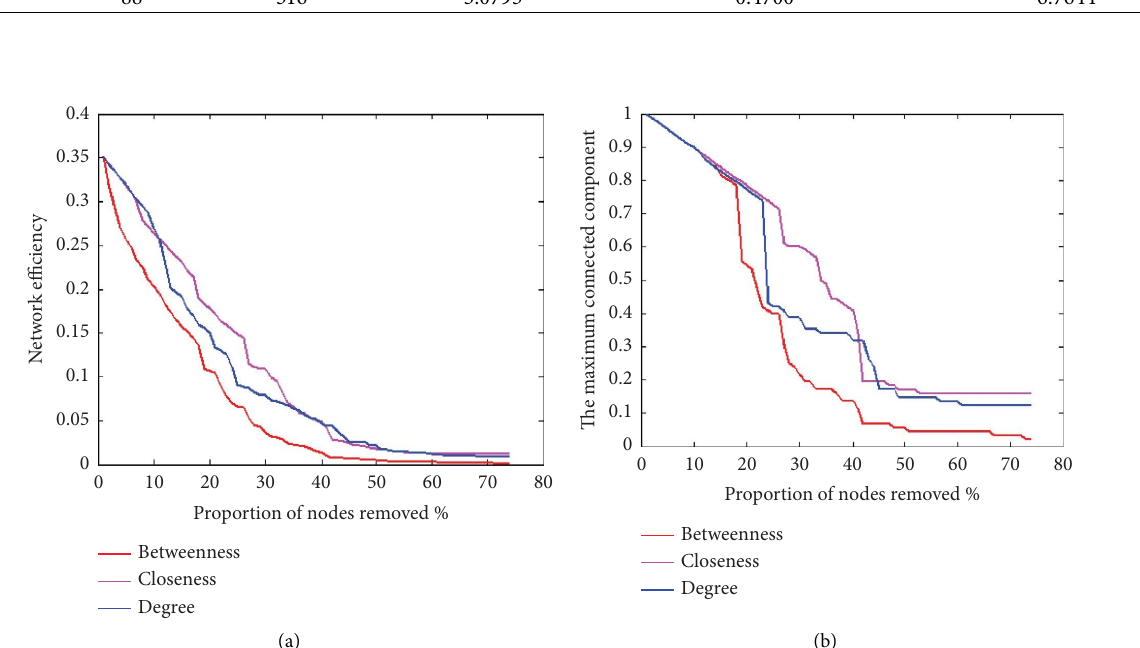
Figure 13: Te robustness of ACMN under diferent attack strategies. (a) Network efciency. (b) Maximum connected component.